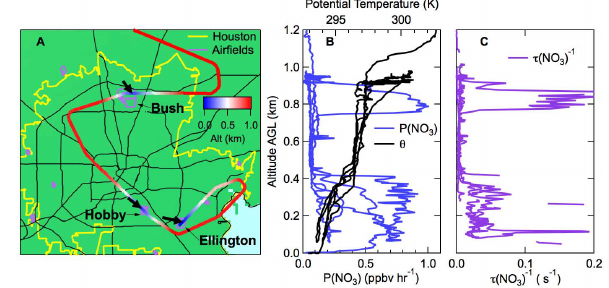
Fig. 5. (A) Same as Fig. 2, except for the latter portion of the P-3 flight track on 10–11 October.